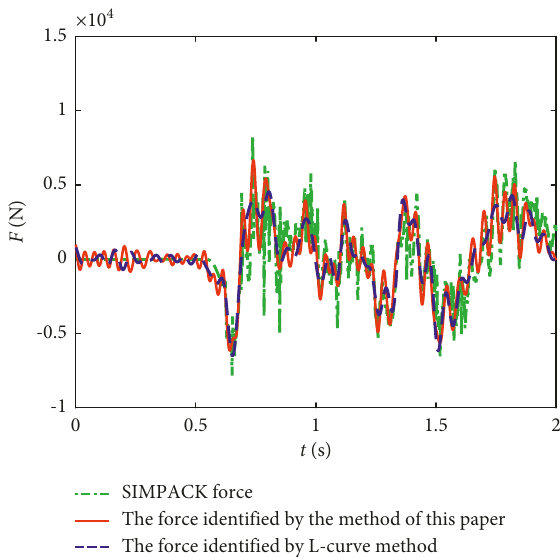
2 Figure 9: Load time-history diagram of the two methods for F identification when the noise level is